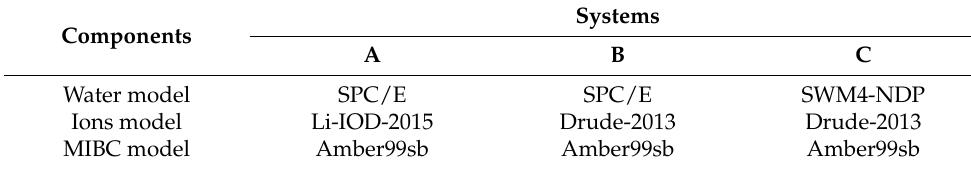
Table 2. Systems considered and force